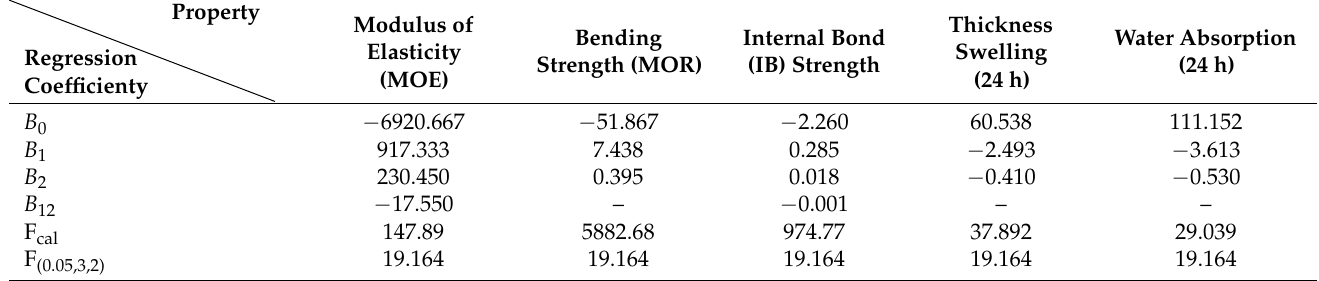
Table 4. Regression models for the effect of total binder content and PF resin content in the adhesive system on the properties of the fiberboard panels produced in this work.